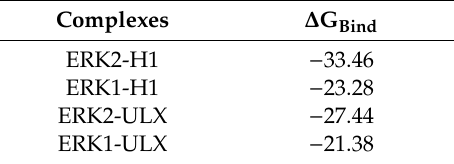
Table 6. Calculated binding free energies [ ∆ G bind ] of the ERK-1 / 2 bound ligands.